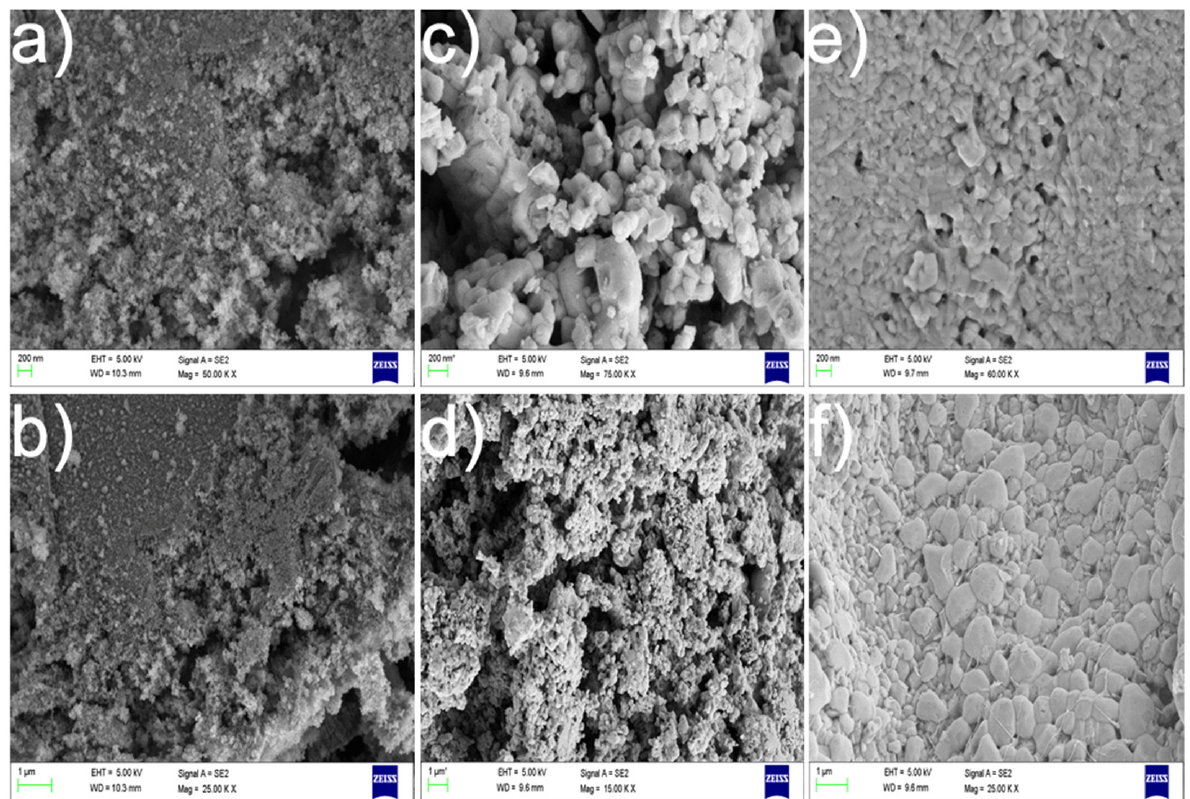
Figure 5. FESEM images of BFO (0% ( a , b ), 2% ( c , d ) and 5% ( e , f ) of excess bismuth BFO) samples.